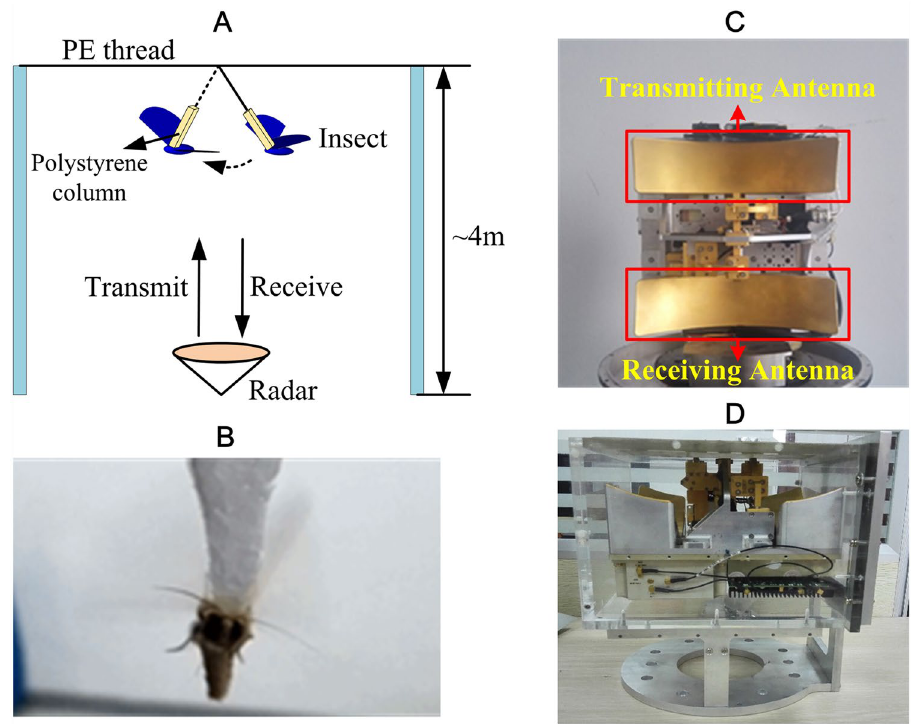
Figure 1. ( A ) The experimental geometry of wingbeat frequency measurement; ( B ) The suspended Mythimna separata ; ( C ) The W-band coherent radar (top view); ( D ) The W-band radar (side view). Note: The radar system has dual-antenna design for transmitting and receiving to solve the radar blind distance problem. These two antennas are corresponding to the top and bottom golden components as marked in Fig.